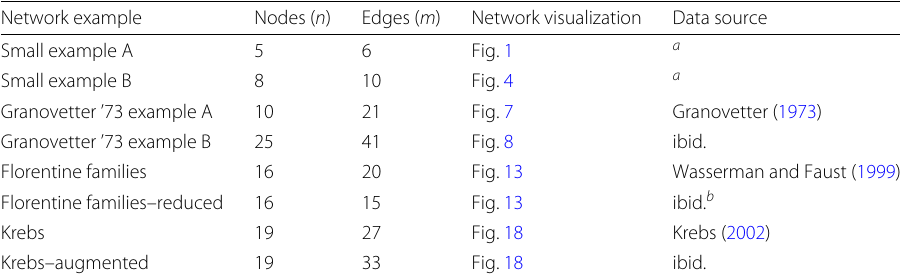
Table 1 Network examples and case studies used in this paper–i.e., a summary of inputs with their sources when applicable Network